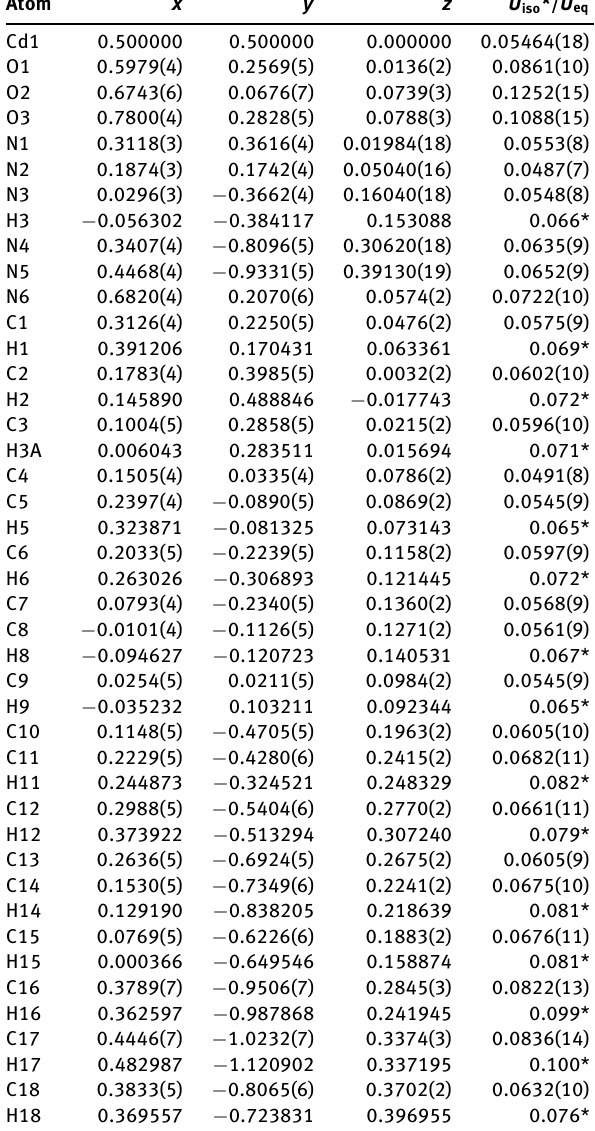
Table 2: Fractional atomic coordinates and isotropic or equivalent isotropic displacement parameters (Å 2